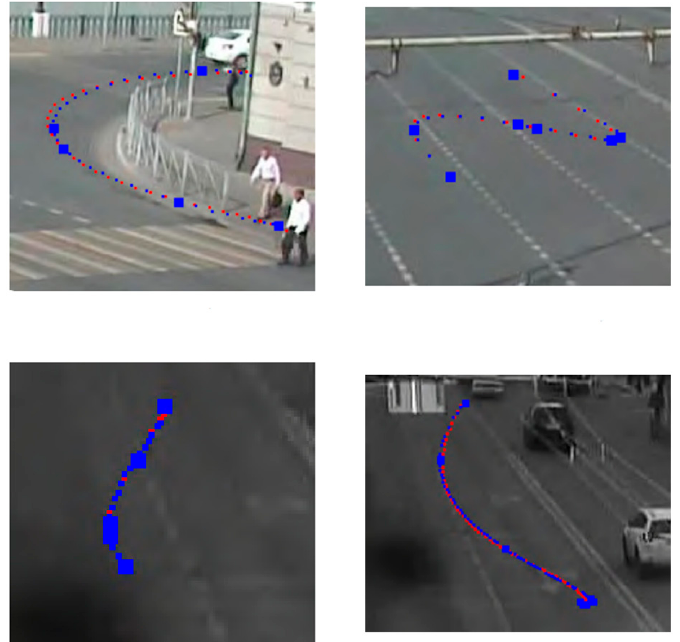
Figure 9. Trajectory approximation and key points. Table 2. Length and positional errors for trajectories, approximated with RDP N.